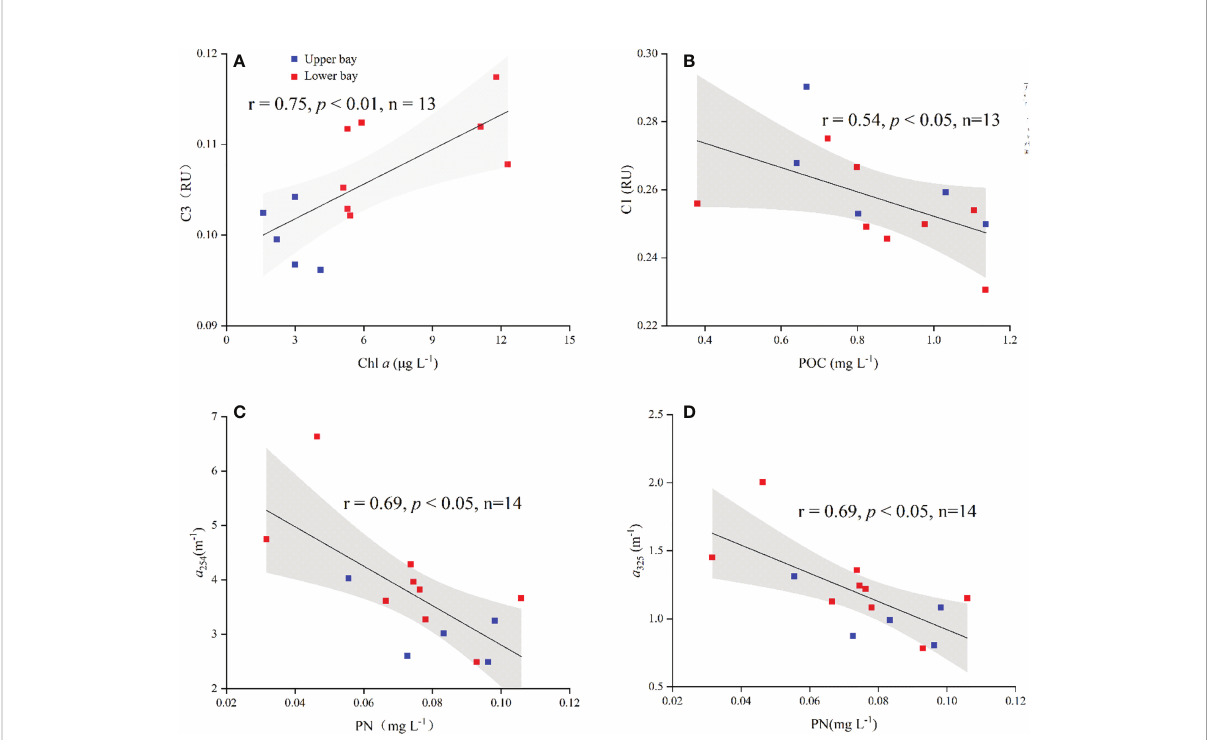
FIGURE 9 (A) Relationships between C3 and Chl a , (B) C1 and POC, (C) a 254 and PN, and (D) a 325 and PN in Xi Bay. The black lines and gray shadows represent the linear fi t lines and 95% con fi dence bands. Because the C1 and C3 fl uorescence intensity in station W14 had no dates, these points were excluded from the